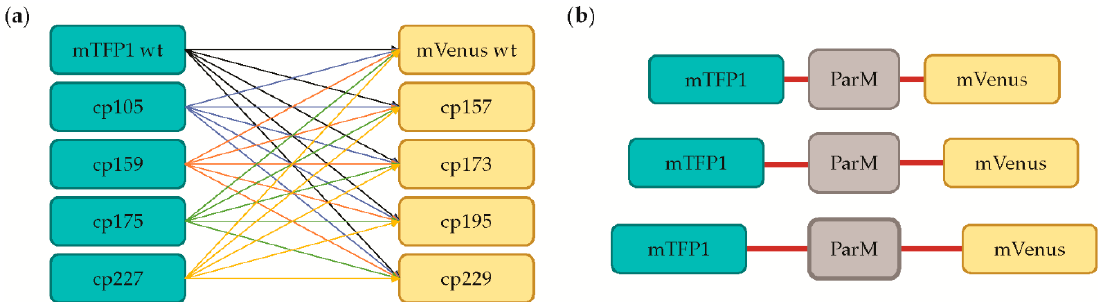
Figure 2. Diagram of ADP sensor libraries. ( a ) Different relative orientations between the mTFP1 and mVenus FRET pair was achieved through the circular permutation kit developed by Pertz and co-workers [18]; ( b ) In addition, different linker lengths and linker compositions were screened.